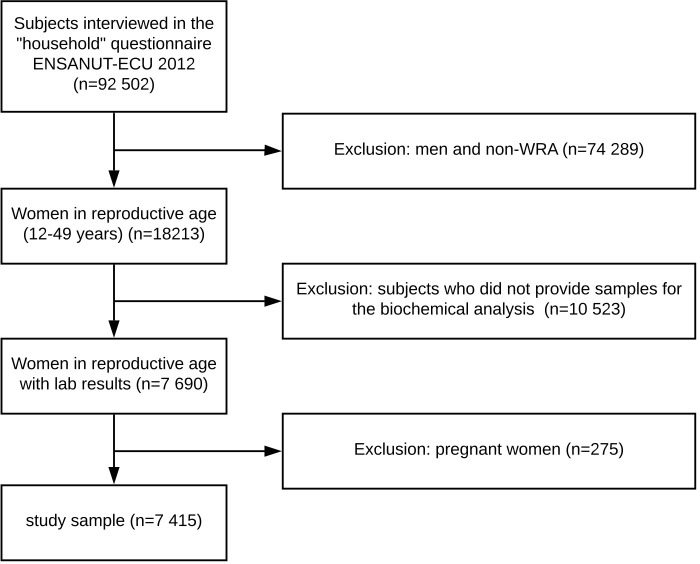
Flowchart of study selection process.